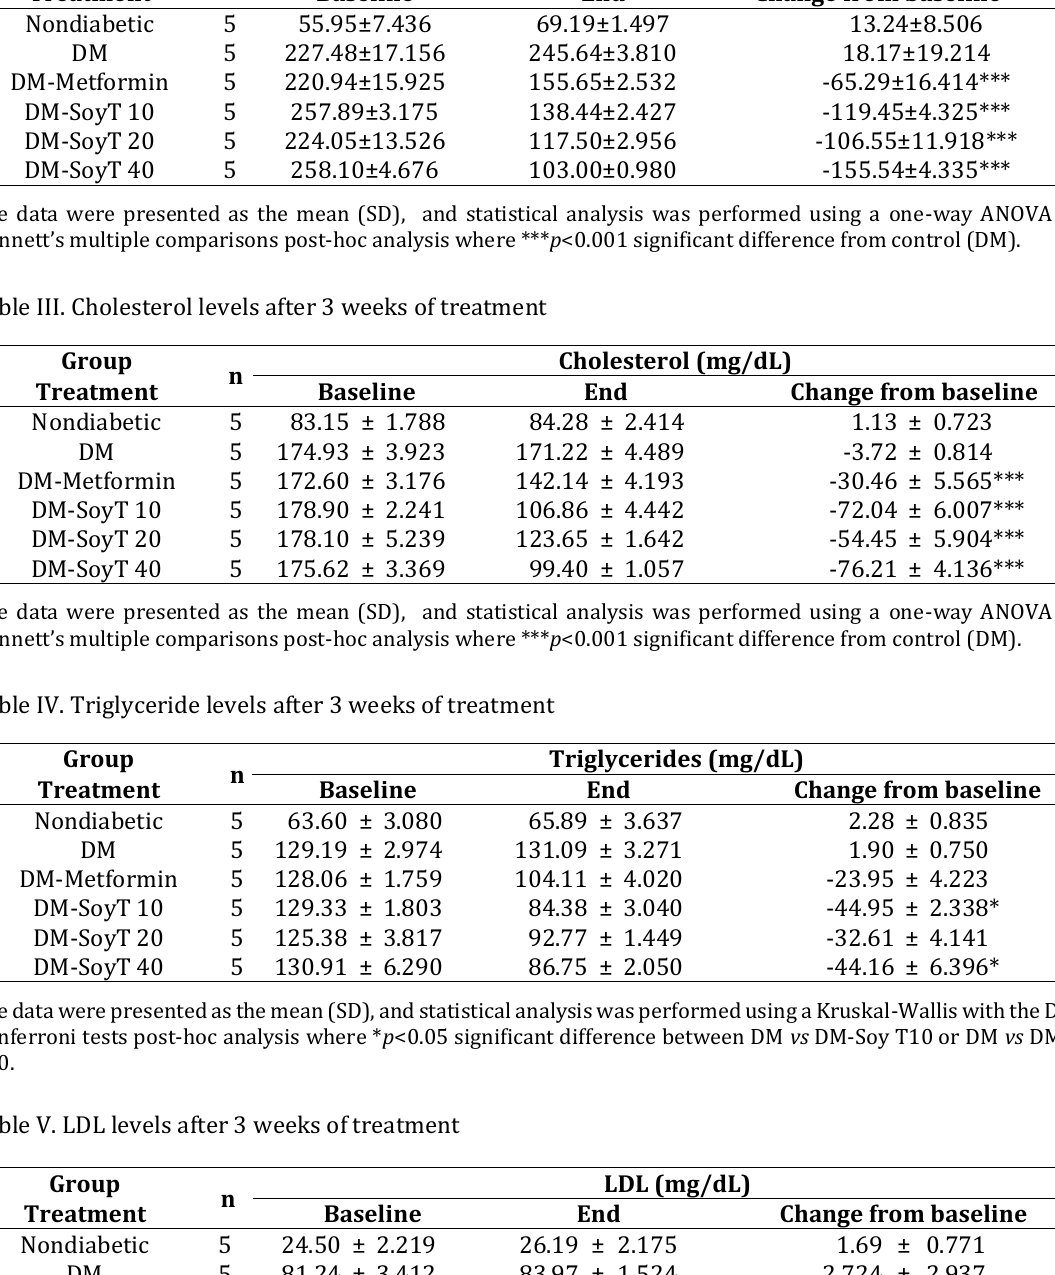
Table II. Plasma glucose levels after 3 weeks of treatment Group